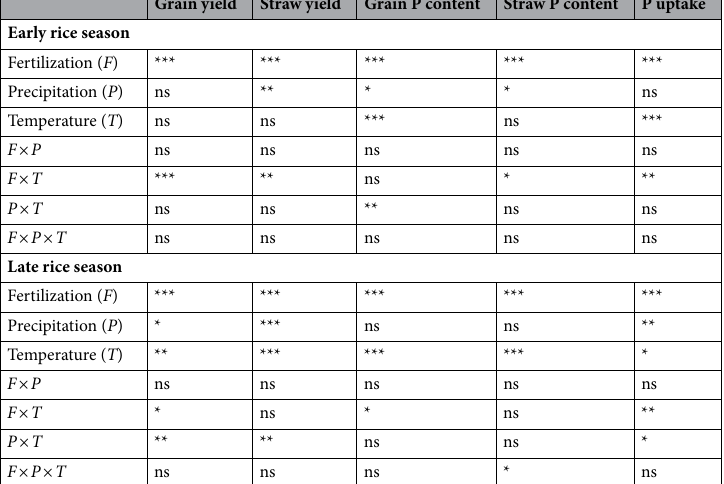
Grain yield Straw yield Grain P content Straw P content P